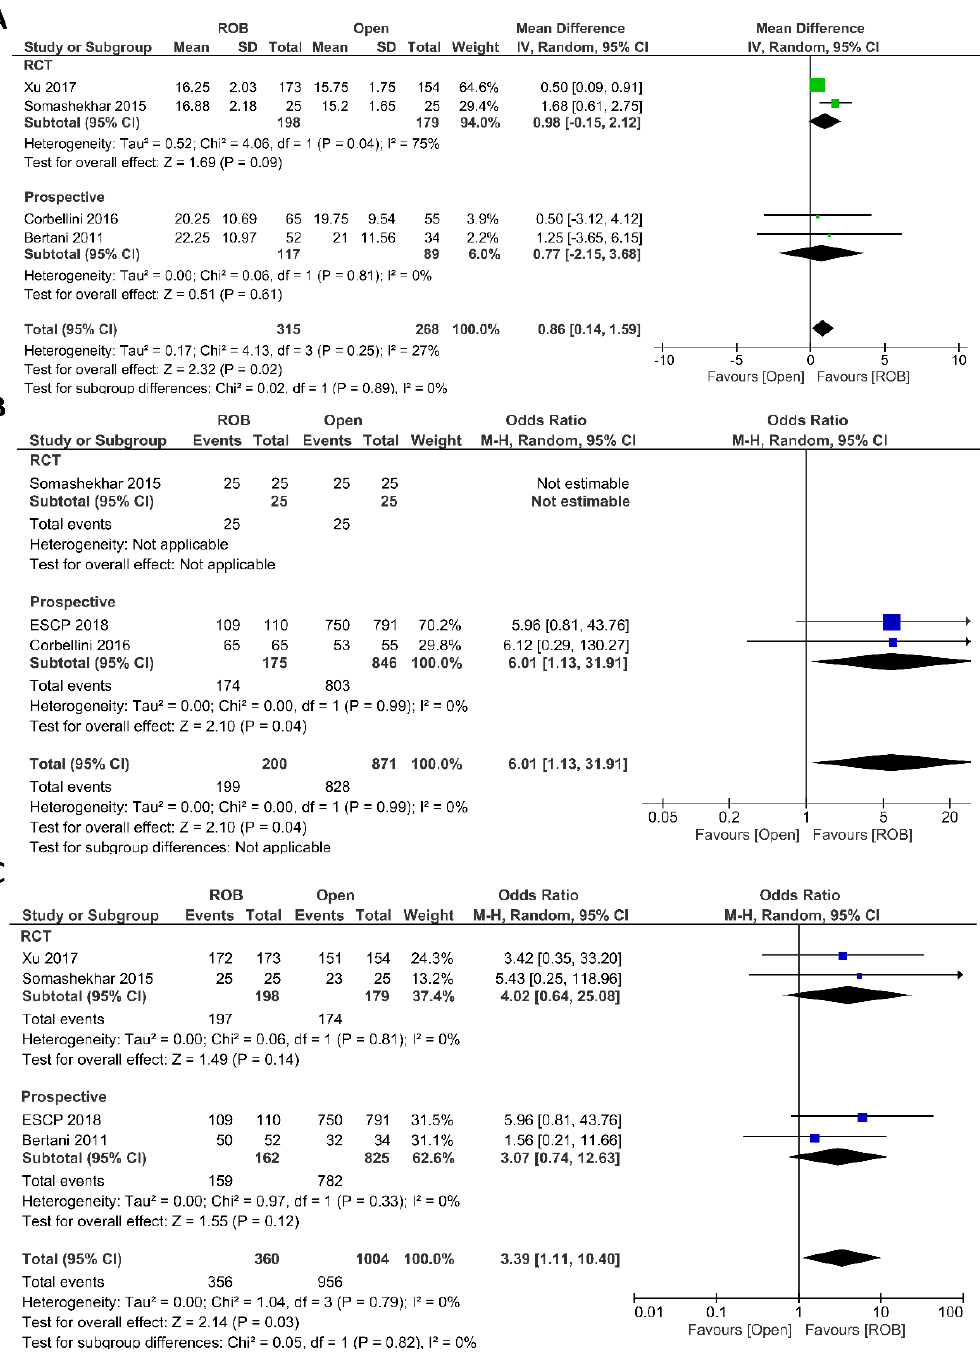
Figure 5. Forest plots comparing ( A ) number of harvested lymph nodes [18,20,40,46], ( B ) microscopic margin-free (R0) resection [18,20,44] and ( C ) circumferential resection margin (CRM) [20,40,44,46] between robotic and open rectal resection (blue boxes representing odd ratios, green boxes representing mean differences, arrows representing 95% confidence intervals, and diamonds representing point estimates of pooled odd ratios or mean differences).